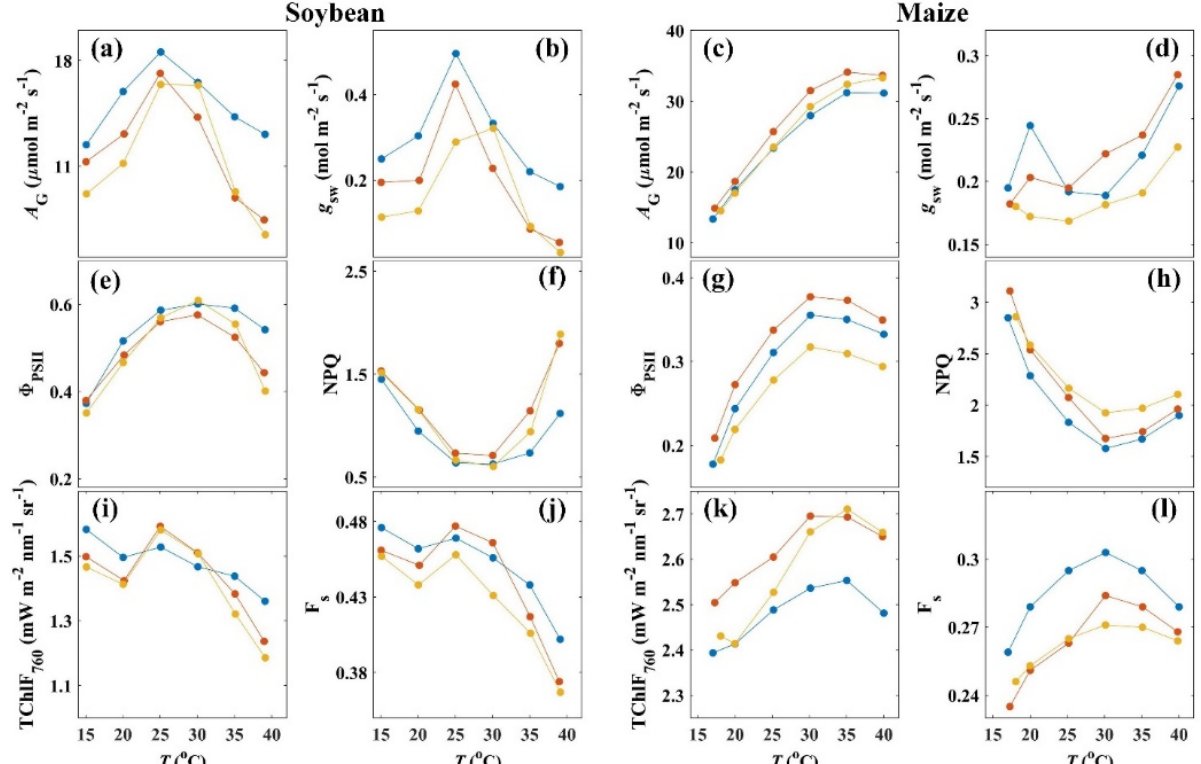
Figure 4. Variation in gross carbon assimilation ( A G , μ mol m − 2 s − 1 , ( a , c )), stomatal conductance to water vapor ( g sw , mol m − 2 s − 1 , ( b , d )), quantum efficiency of photosystem II ( Φ PSII , ( e , g )), nonphotochemical quenching (NPQ, ( f , h )), total fluorescence radiance at 760 nm measured from both sides of leaves (TChlF 760 , mW m − 2 nm − 1 sr − 1 , ( i , k )), and light-adapted steady-state PAM fluorescence (F s , ( j , l )) with leaf temperature ( T , ◦ C) measured on three leaves of soybean (left two columns) and maize (right two columns) under irradiance of 800 (soybean) and 1200 (maize) µ mol m − 2 s − 1 . The three different colored lines represent three individual samples. n T = 6 for each leaf.